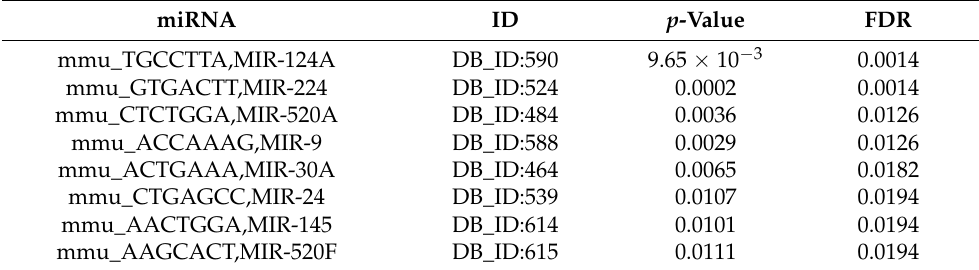
Table 4. Related miRNAs list.